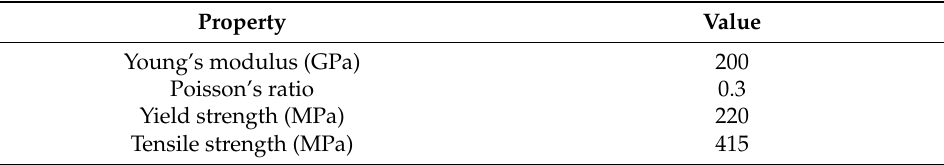
Table 2. Material properties of ASTM SA516 Grade 60.